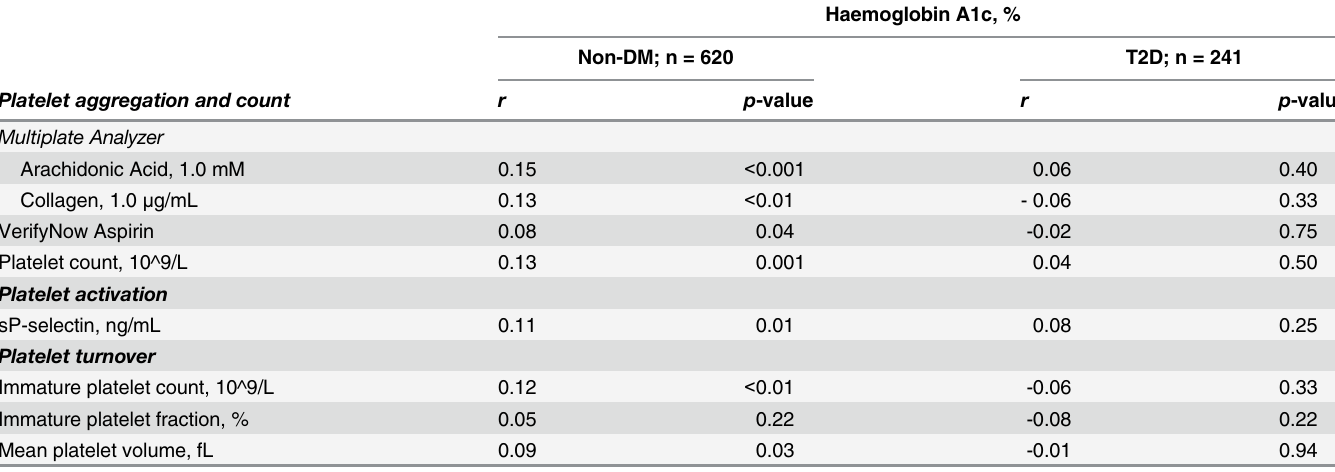
Table 3. Correlation between HbA1c and platelet parameters in coronary artery disease patients, n = 861 * . Haemoglobin A1c, % Non-DM; n = 620 T2D; n = 241 Platelet aggregation and count r p -value r p